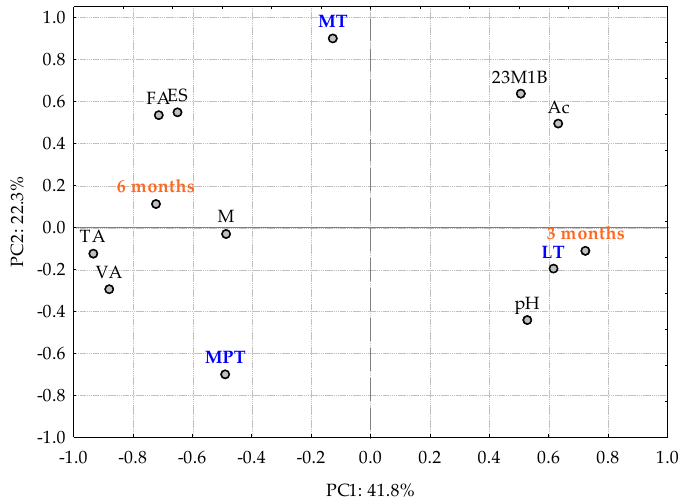
Figure 2. Principal component analysis of the physicochemical determination, and significant volatile compounds of Arbutus unedo spirits aged with oak, with three different toasting levels (LT–AUS aged in light toasting oak wood; MT–AUS aged in medium toasting oak wood; MPT–aged with medium plus toast oak wood) during three and six months. M—Methanol (g/mL); Ac—Acetaldehyde (mg/L); 23M1B—2+3-methylbutan-1-ol (mg/L); DS—dry extract (g/L); VA—Volatile acidity; TA–total acidity; FA–fixed acidity.